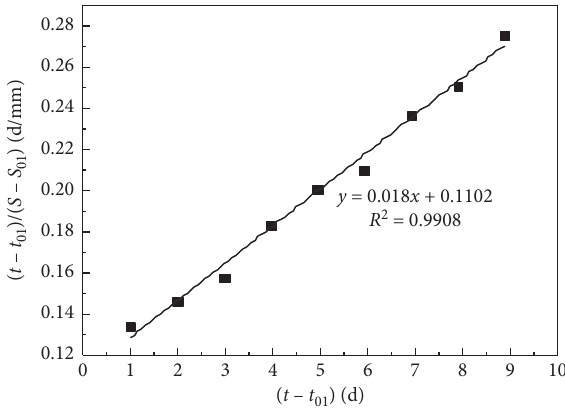
Figure 8: Relationship of ( t − t